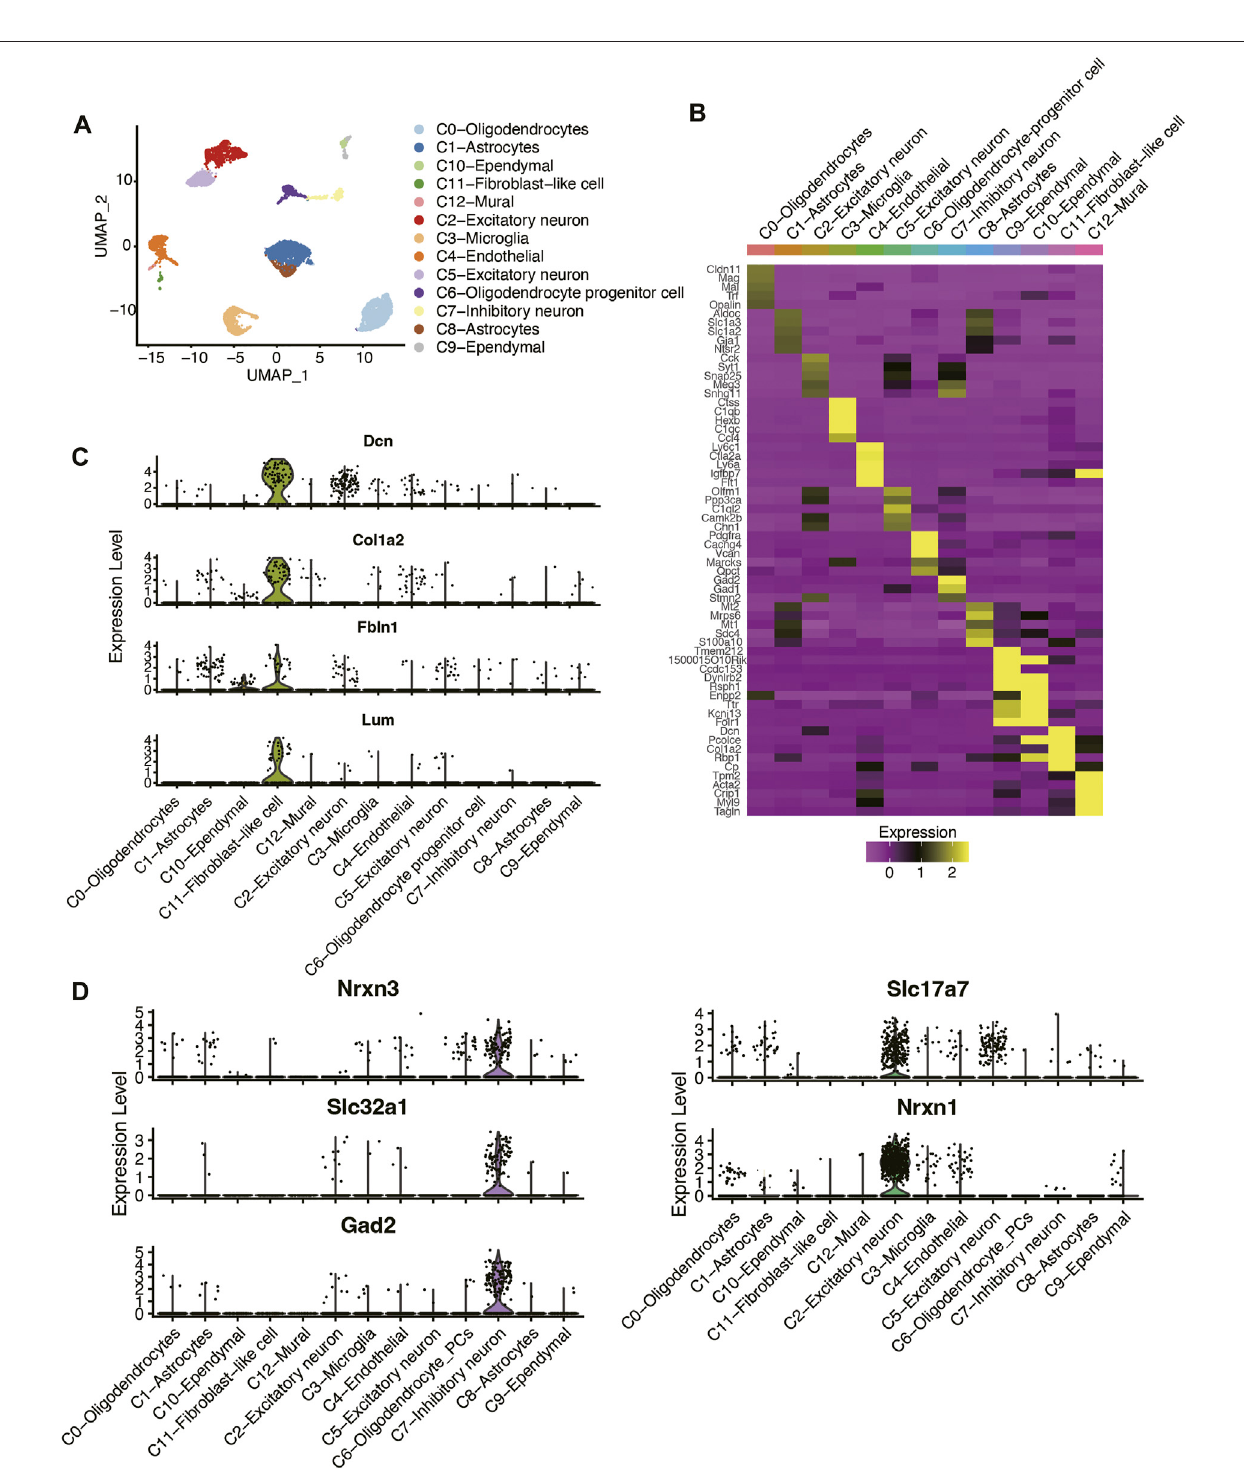
FIGURE1| Classi fi cation andmolecularcharacterizationofthecelltypes inmousehippocampus ofTBIandSham samples. (A) TheUMAP analysisforthemouse hippocampus samples. Each point represents one cell, and the point colors represent the cell clusters. (B) The expression patterns of the cell type maker genes across the cell types. The expression levels of (C) fi broblast-like cell, (D) excitatory neuron, and inhibitory neuron marker genes across the cell types.